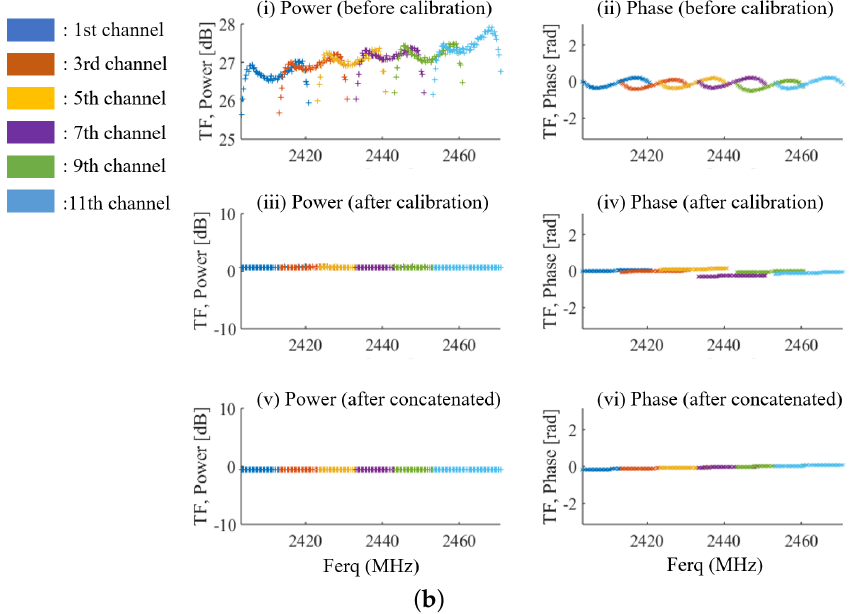
Figure 6. B2B calibration. ( a ) Calibration procedure. ( b ) Calibration